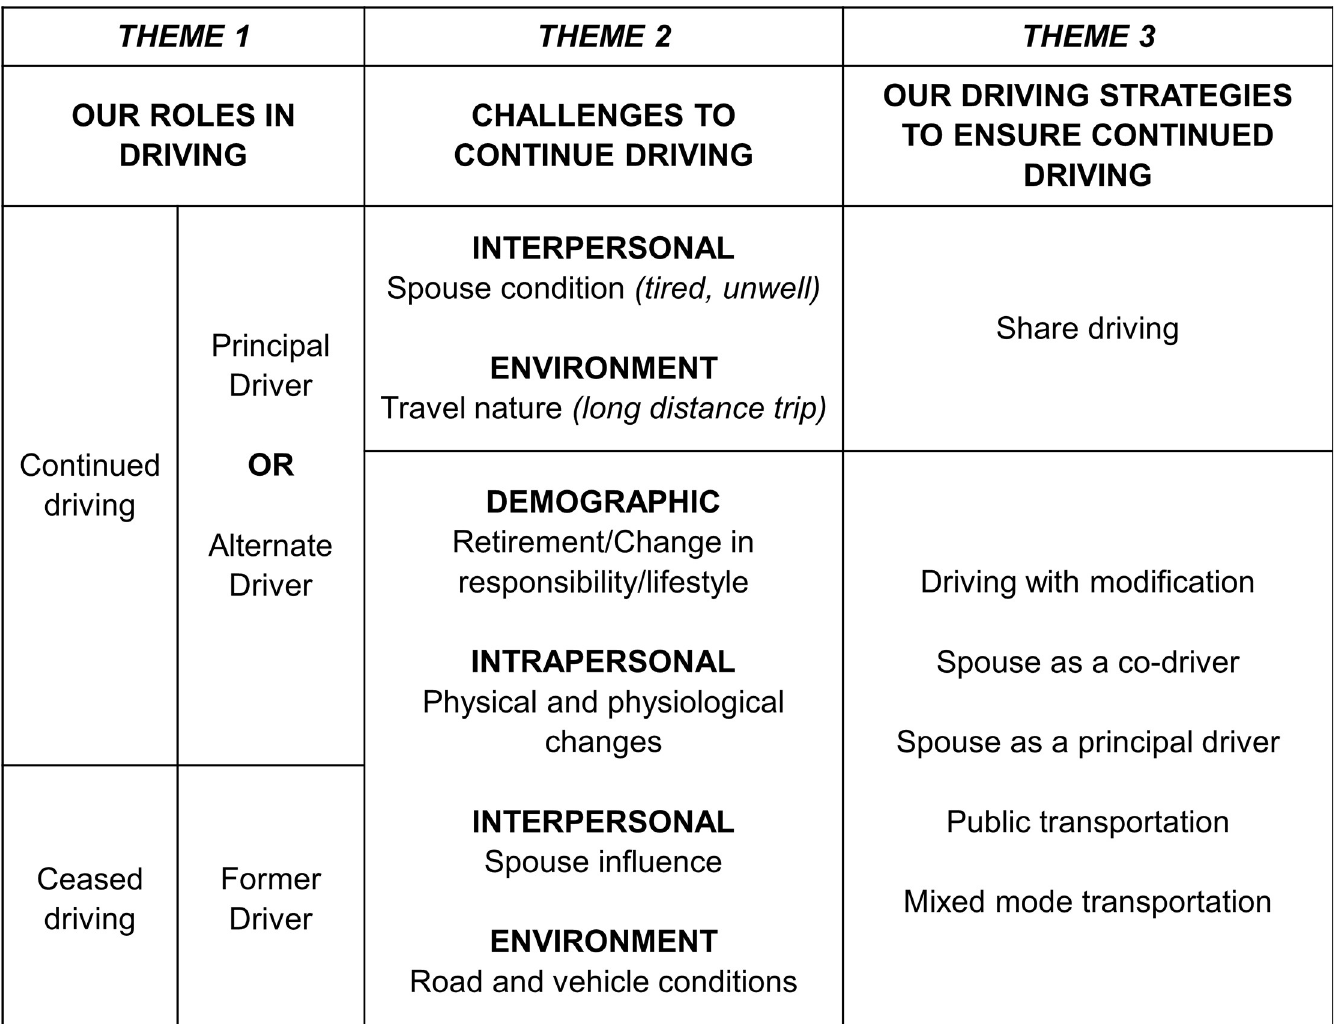
Fig 1. Summary of driving roles, obstacles, and strategies adopted by older married